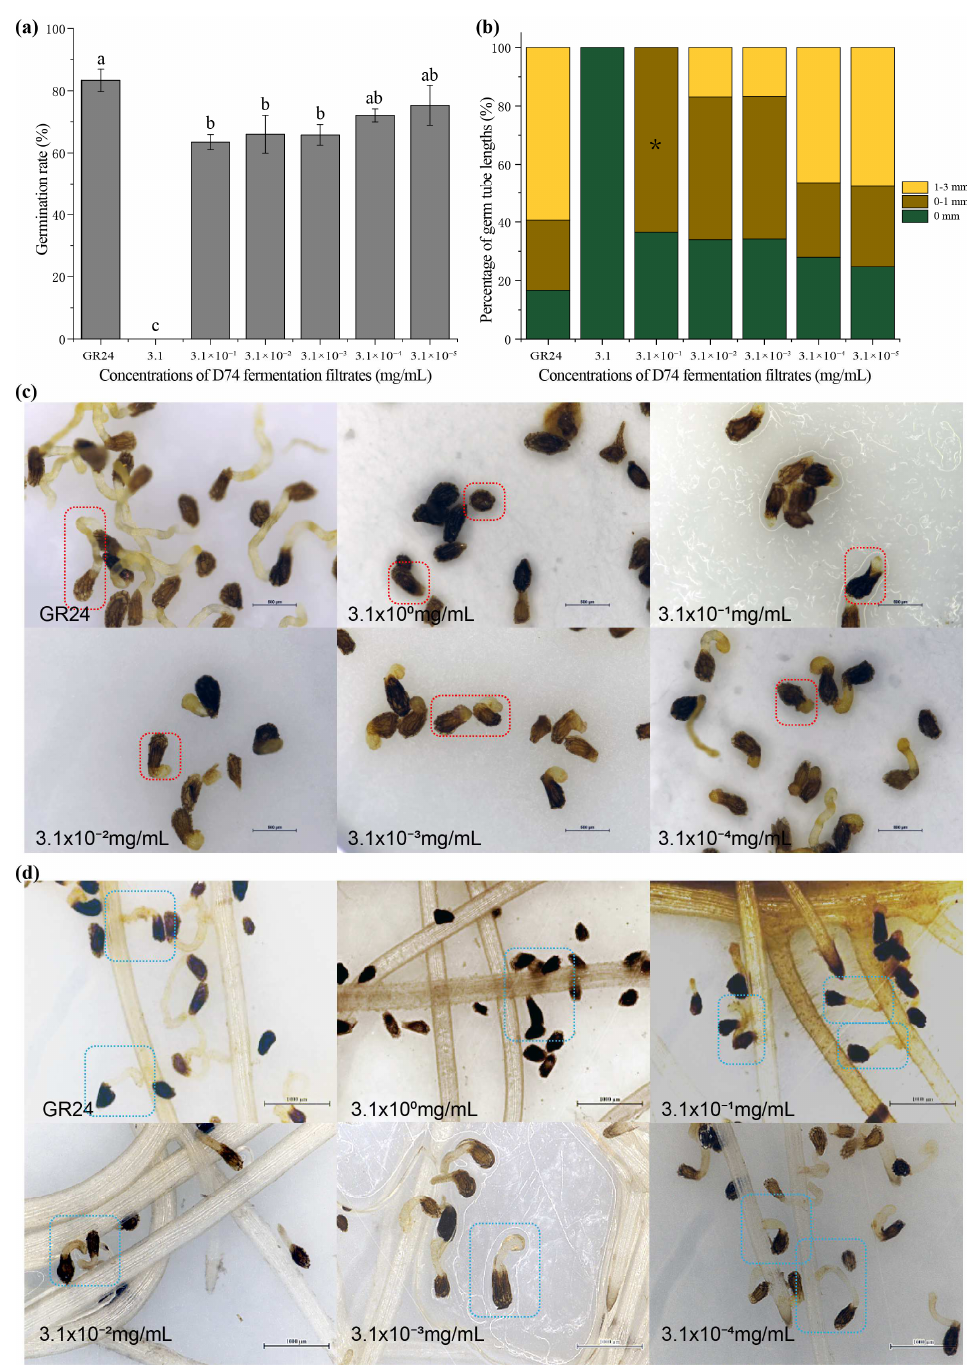
Figure 1. Effects of different concentrations of D74 fermentation filtrates on the germination rate ( a , c ), germ tube length ( b ), and parasitism ( d ) of O. cumana seeds. Different letters indicate significant differences between the groups (Tukey’s test, p < 0.05), bar: 1000 µm. * Critical level of significance of constructs at 10%.